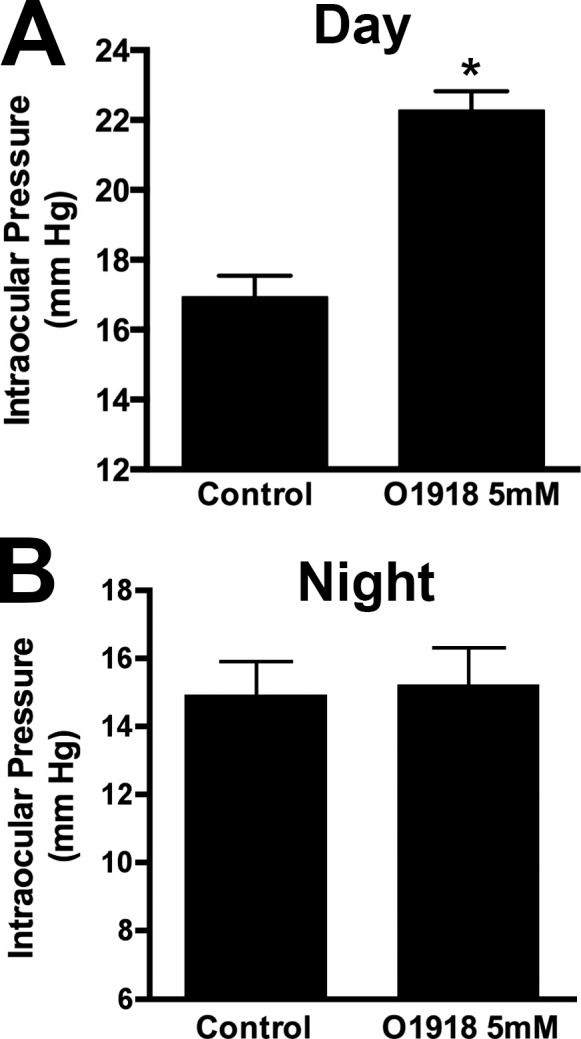
The GPR18 antagonist O-1918 raises IOP during the day but not at night. (A) Intraocular pressure in O-1918–treated versus control eye in midday treatments. (B) Same treatment in separate group of animals under reverse light cycle, equivalent to midnight. *P < 0.05, paired t-test.